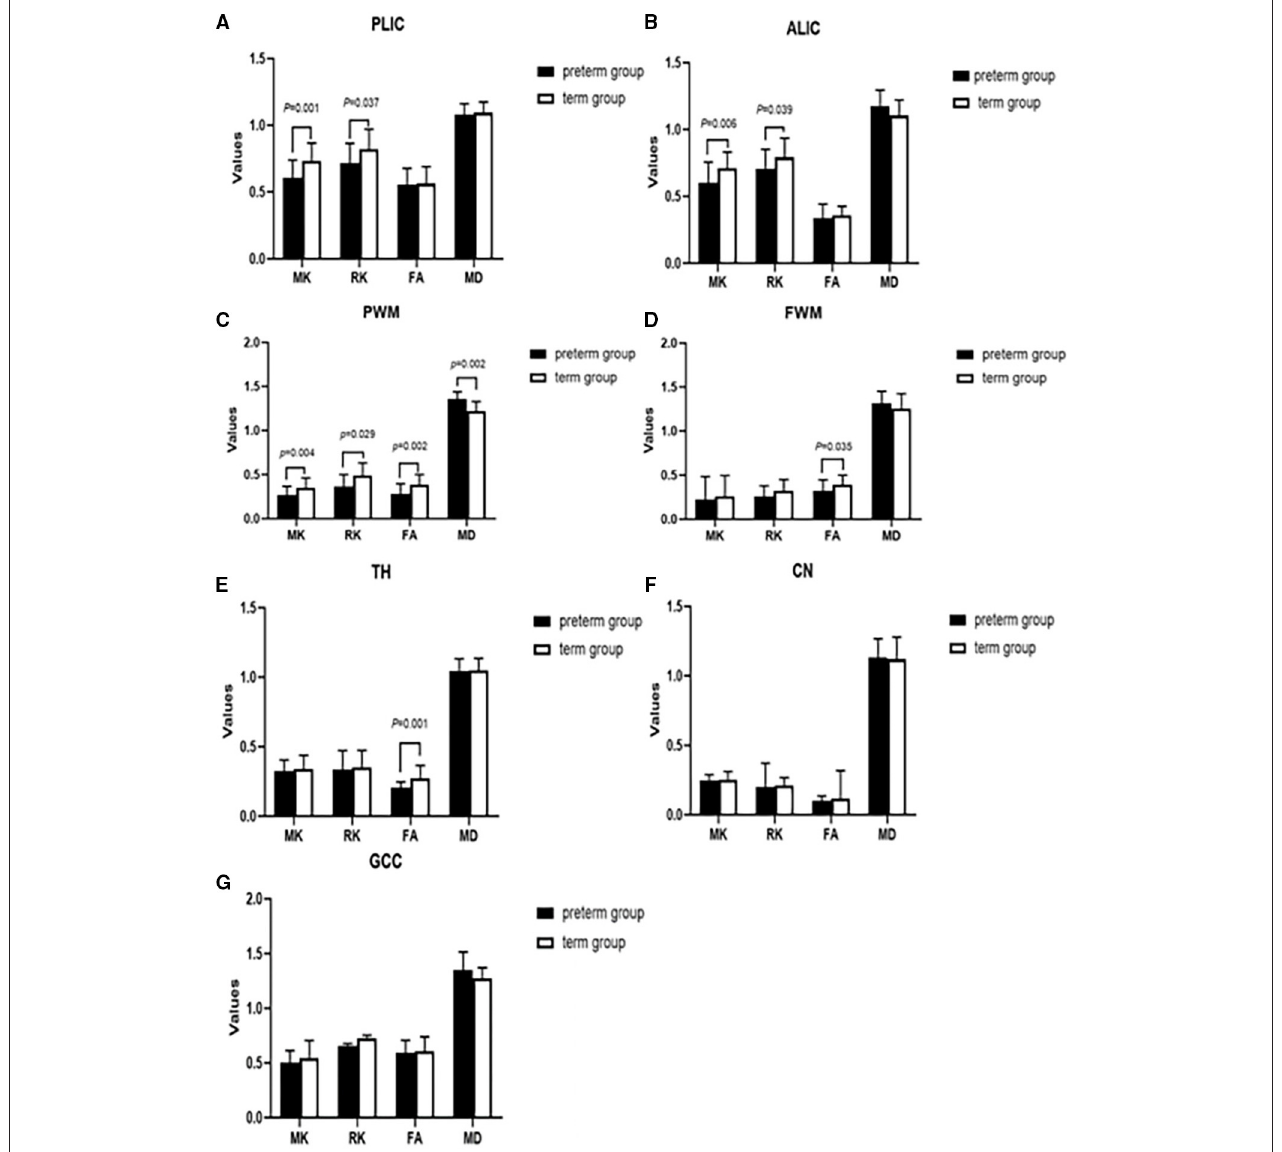
FIGURE 2 | Comparing the difference of parameter values between preterm infants ( n = 26) and term infants ( n = 26) in the different brain regions (A–G) . Black represented premature infants, white represented full-term infants. PLIC, posterior limbs of the internal capsule; ALIC, anterior limb of internal capsule; PWM, parietal white matter; FWM, frontal white matter; TH, thalamus; CN, caudate nucleus; GCC, genu of the corpus callosum; MK, mean kurtosis; RK, radial kurtosis; FA, fractional anisotropy; MD, mean